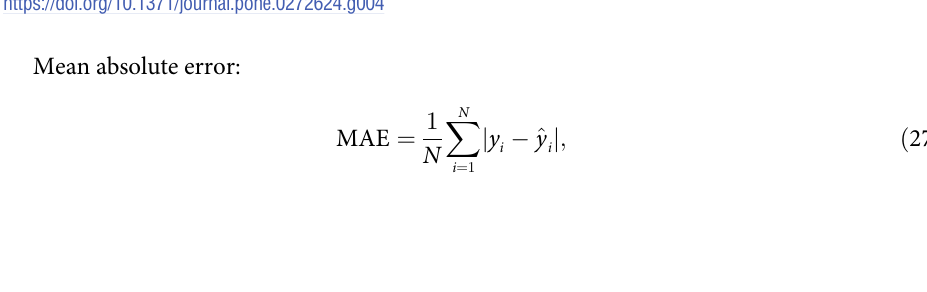
Fig 4. Prediction results of ReLu-FCM and Sig-FCM. (a) ReLu-FCM, (b) Sig-FCM.